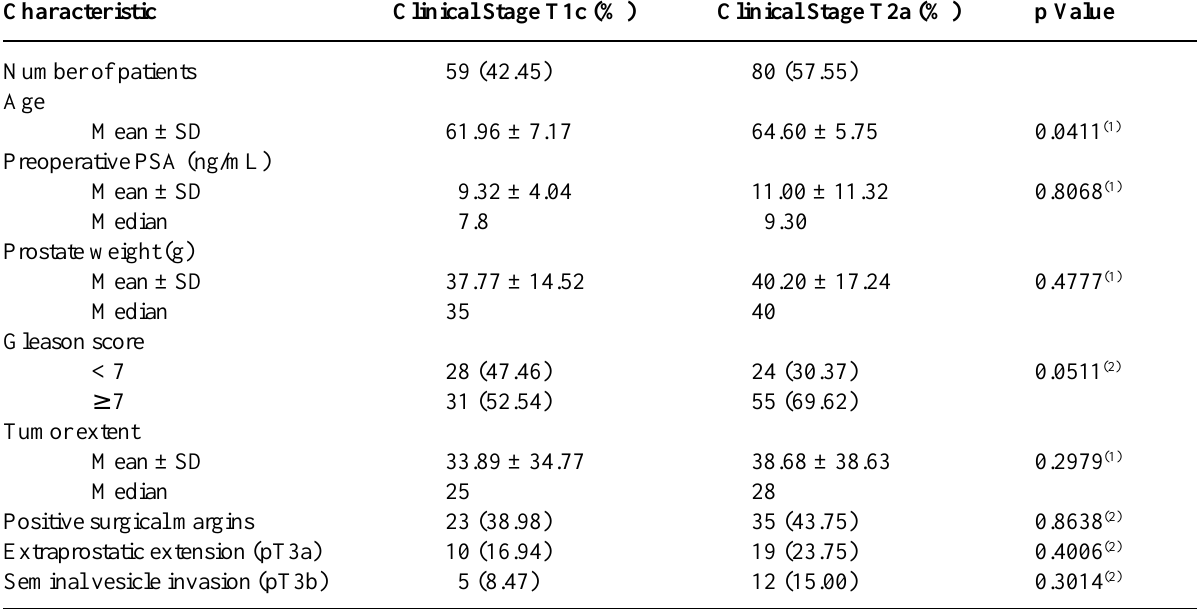
Table 2 – Clinicopathologic features of men undergoing radical prostatectomy, by clinical stage T1c and stage